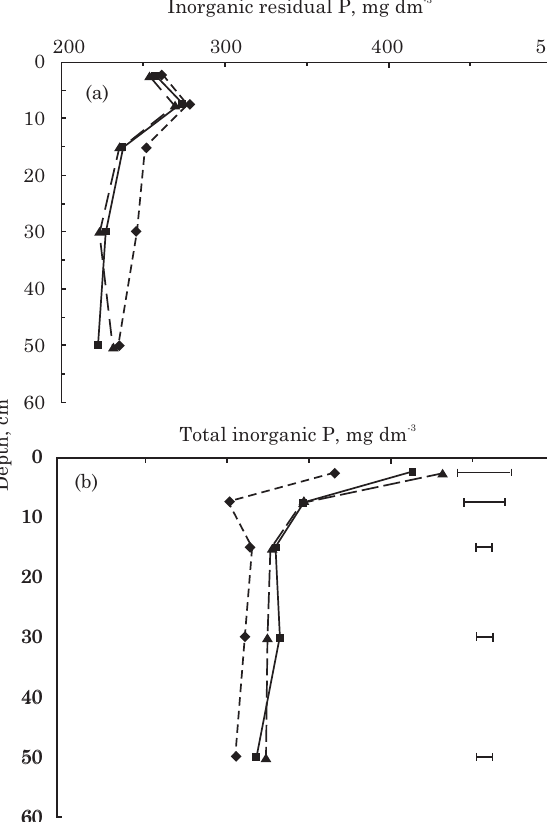
Figure 2. Inorganic Ca-bound and non-labile inorganic soil P as affected by surface- broadcast P fertilizers and depth. (a) Ca-bound inorganic P; (b) Non-labile inorganic P. Dotted line – No P; dashed line - natural reactive Arad phosphate; solid line – triple superphosphate. Horizontal bars show LSD (p<0.05) and compare treatments within each soil depth.